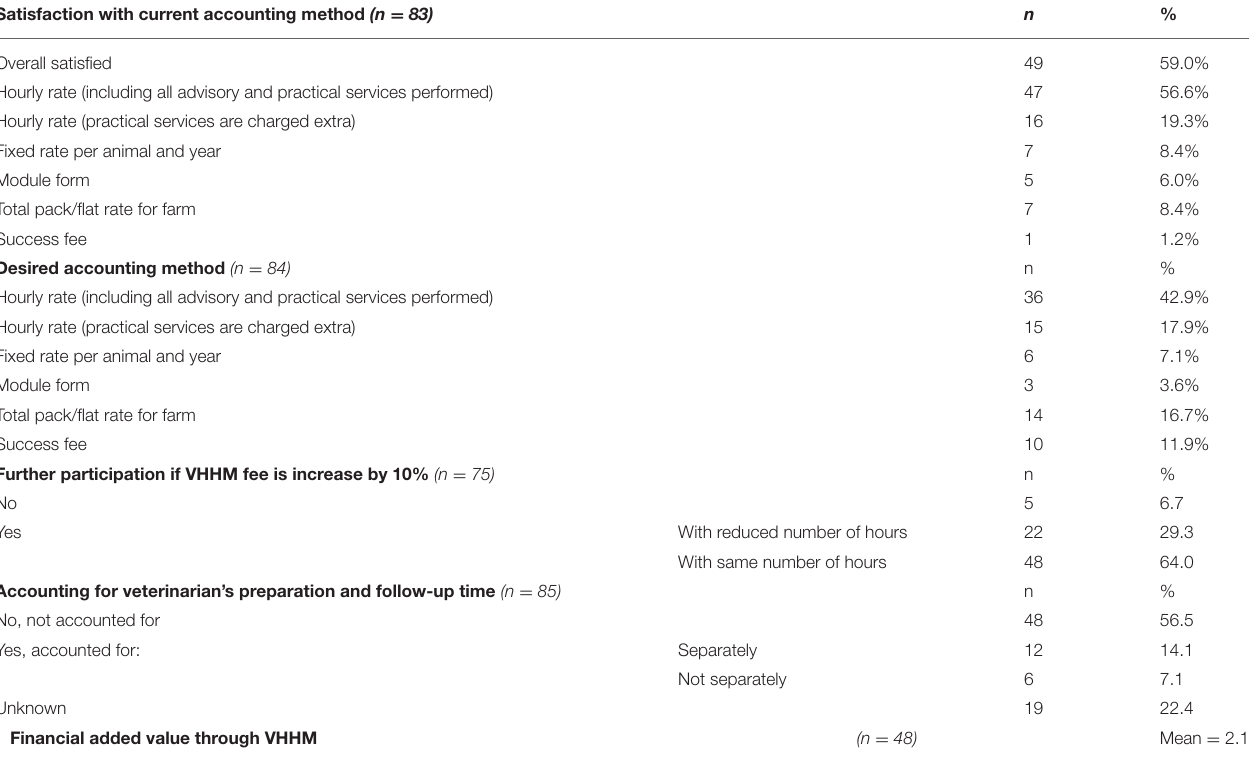
TABLE 8 | VHHM: Accounting method. Satisfaction with current accounting method (n =